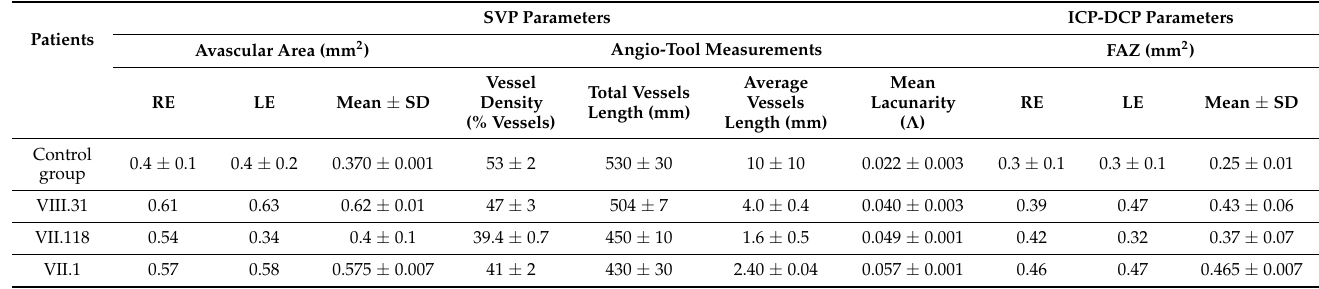
Table 3. Quantitative analysis of retinal plexuses.